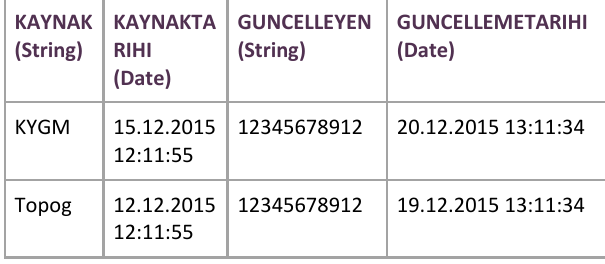
Table 1. Feature based metadata field examples